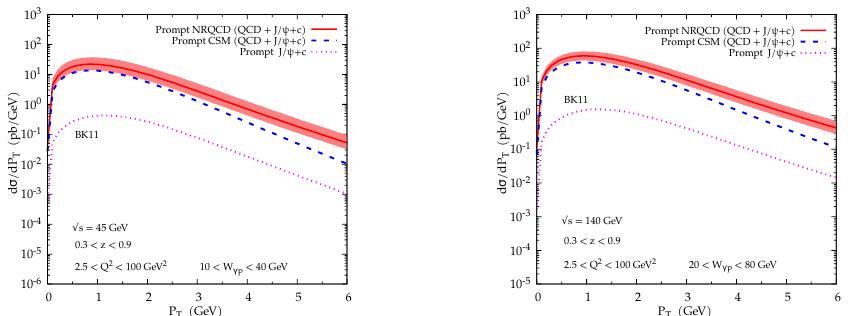
Figure 1: Unpolarized differential cross section estimates as a function of P for the (cid:112) T s = 45 GeV (left panel) and 140 GeV (right panel), process ep → e + J /ψ + X at obtained adopting the BK11 LDME set [ 18 ] : NRQCD (red solid line), CSM (blue dashed line) and intrinsic charm contribution J /ψ + c (magenta dotted line). The / 2 to 2 M band is obtained by varying the factorization scale from M . T T